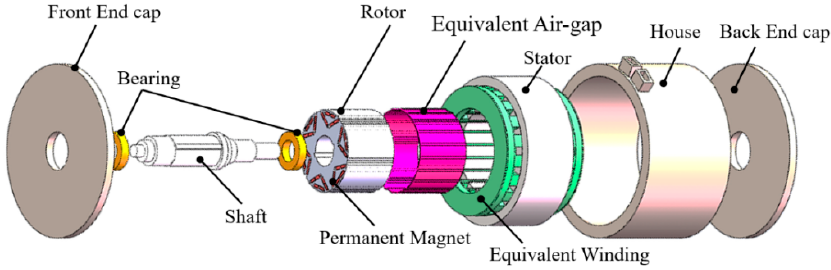
Figure 23. A 60 kW high power density machine temperature field solution model.